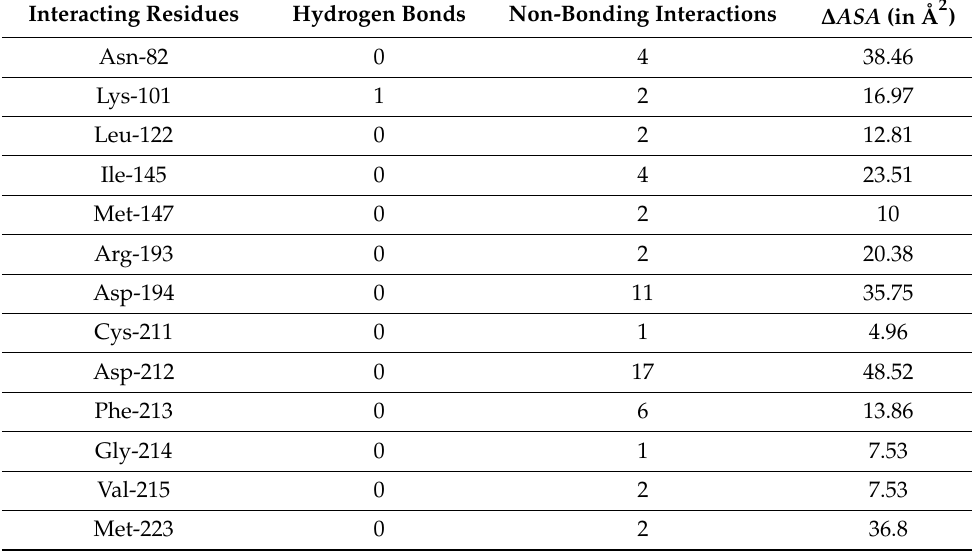
Table A2. The MEK2 residues interacting with selected flavonoid M2F2 are listed with the number of non-bonding interactions and ∆ ASA .